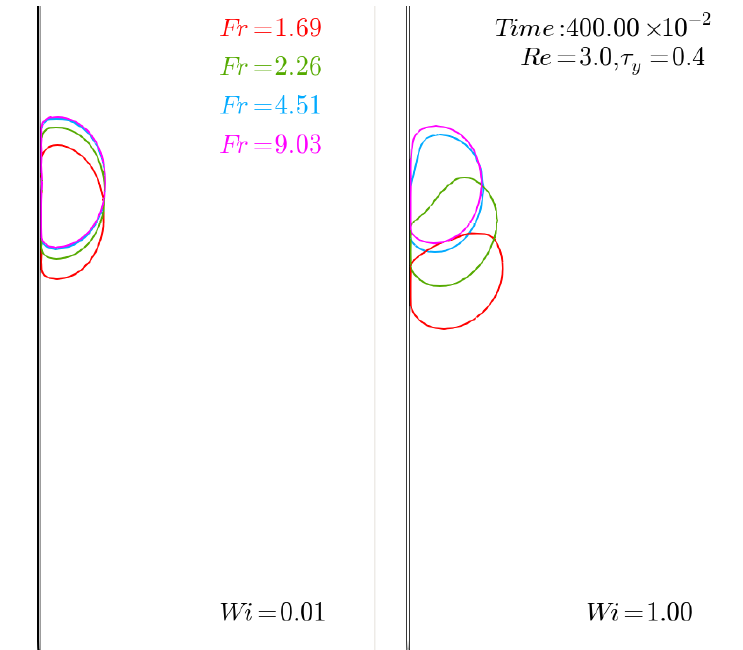
Figure 5. Collision of drops on a vertical wall for fixed values of the Reynolds, Re = 3, and plastic numbers, τ y = 0.4 and the following values of the Froude number, Fr = { 1.69;2.26;4.51;9.03 } . ( left column ) Wi = 0.01; ( right column ) Wi = 1.0. Dimensionless time, t = 4.